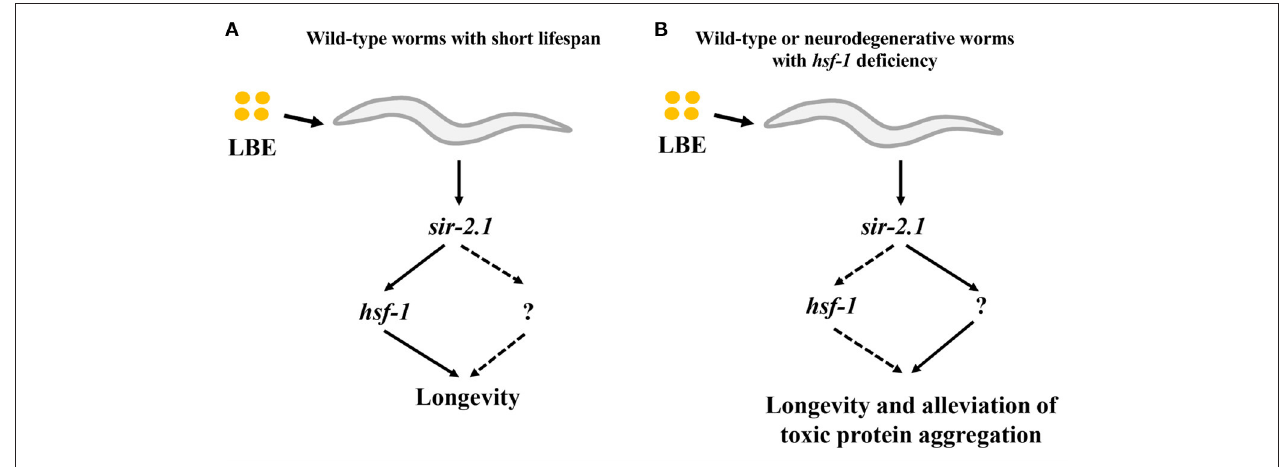
FIGURE 8 | Model of LBE for lifespan extension and alleviation of toxic protein aggregation. (A) For wild-type worms with short lifespan, LBE shows the longevity effect depending on sir-2.1 and hsf-1 pathway. (B) For wild-type or neurodegenerative worms with hsf-1 deficiency, LBE also extends the lifespan and alleviates toxic protein aggregation in a sir-2.1 -dependent manner, possibly through an unknown downstream target. LBE, total water extracts of L. barbarum